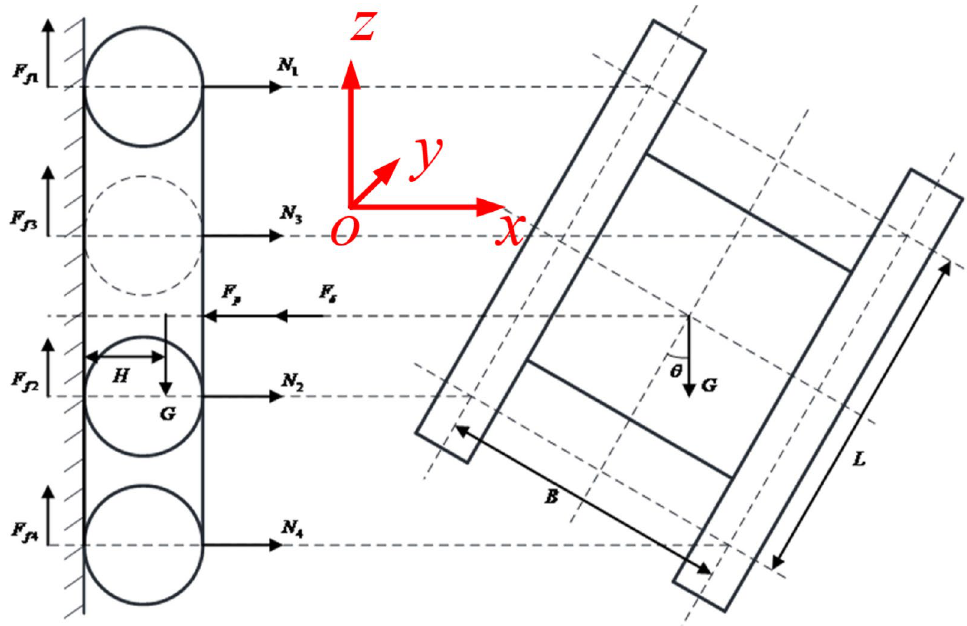
Figure 4. Force analysis of wall-climbing robot at any